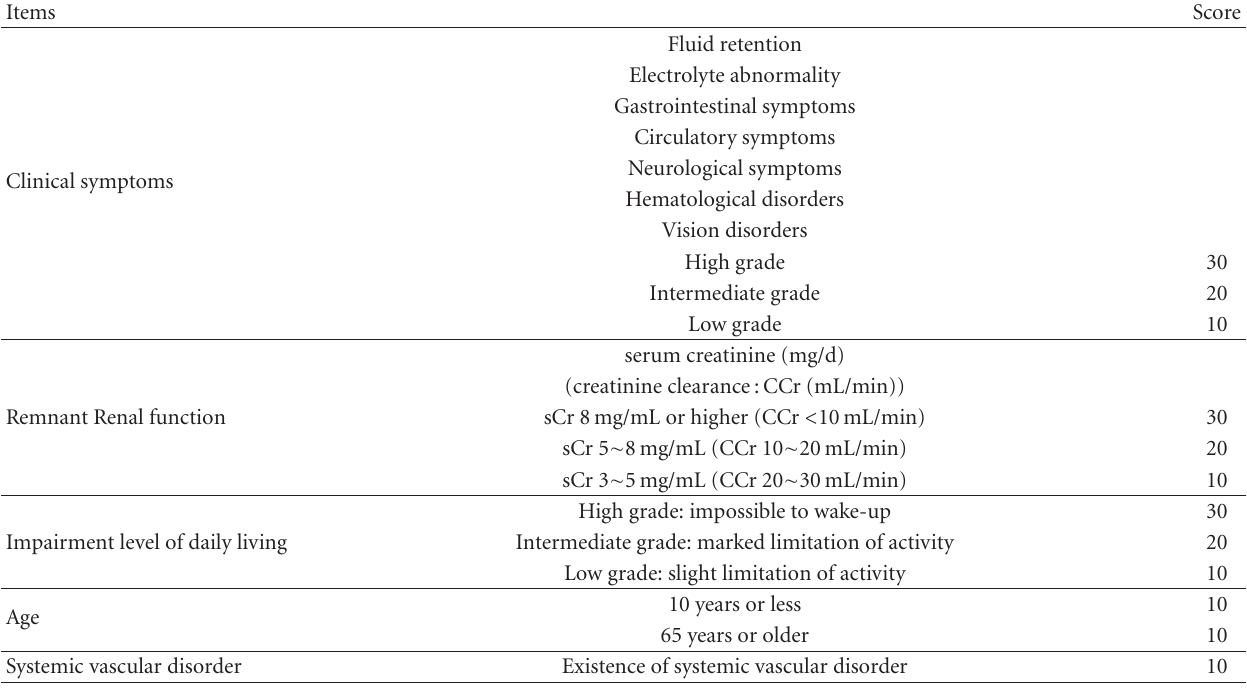
Table 1: Dialysis initiation criteria in Japan. According to the guidelines for introducing patients to dialysis issued by the Ministry of Health, Labour and Welfare of Japan, sum total of 60 or higher is indication for dialysis initiation.